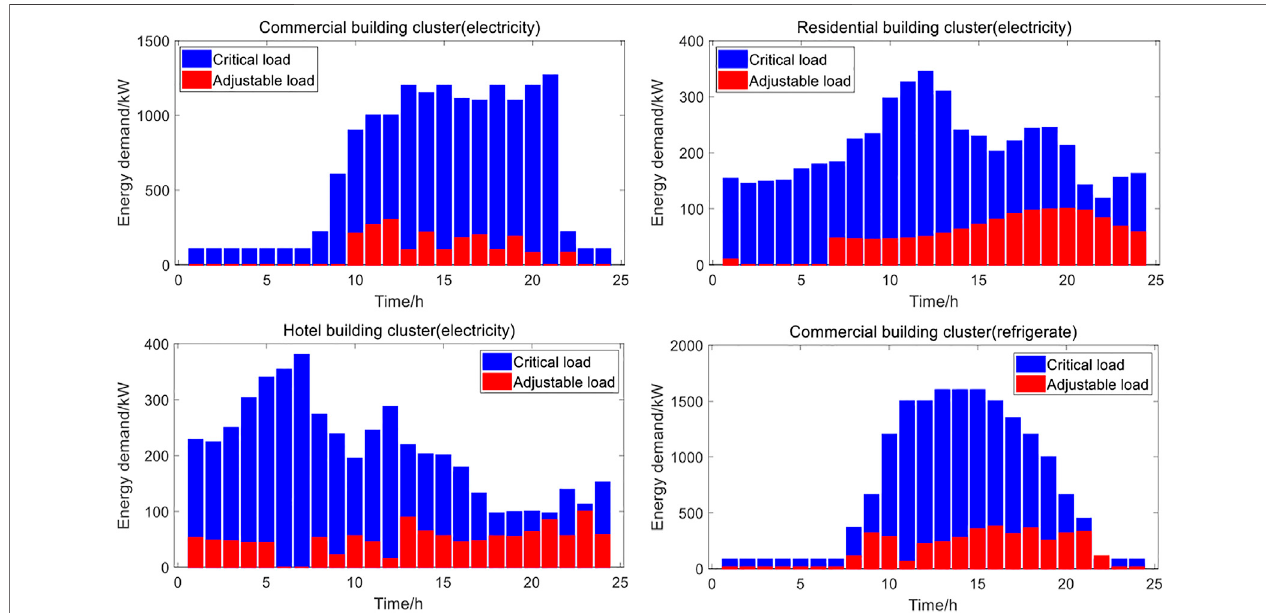
FIGURE 5 | Energy demand pro fi le of three building